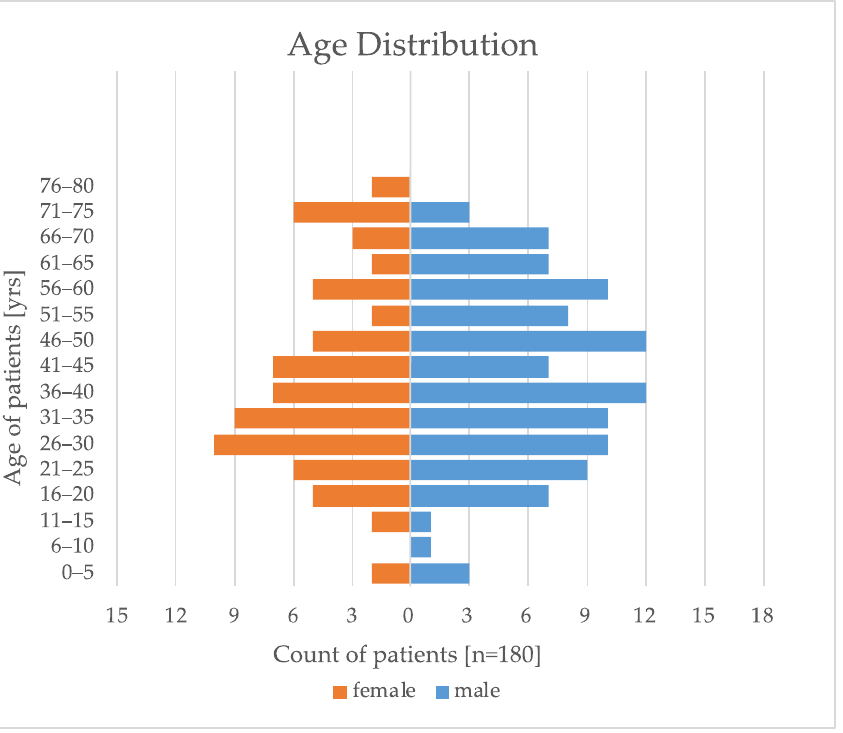
Figure 3. Age–dependent incidence of MM in females (red) and males (blue). The y–axis represents the age of the patients, and the x–axis is the count of female or male patients that were diagnosed with MM. The youngest patient was only 28 weeks old, and the oldest patient was diagnosed at the age of 79 years (Figure 2). The median age of disease onset of female patients was 37 years, and for male patients, it was 42 years. A higher frequency of MM was found in men compared to women (1.4:1).